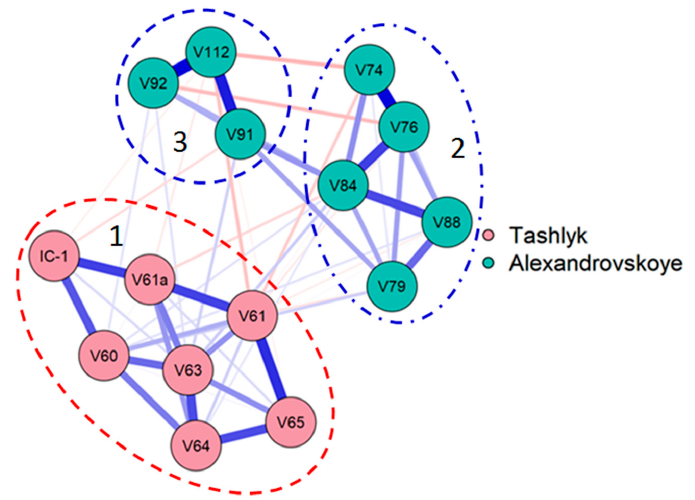
Figure 5. JASP correlation network plot for the communities of the Tashlyk and Alexandrovskoye reservoirs based on the abundance of phytoplankton by station. The corners of the grid are colored according to the relationship to each of the reservoirs. The strongest links are shown by the thickest lines. Positive correlations are shown in blue lines, negative ones in red.